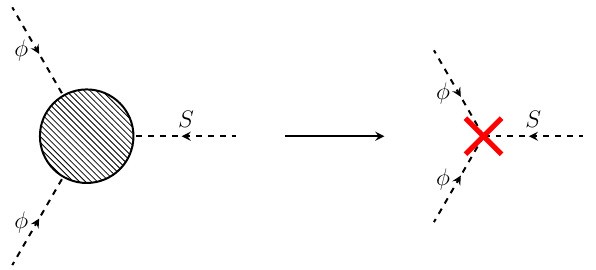
Figure 5 . For the SM Higgs (cid:30) and the scalar singlet S transforming as ( 1 ; 1 ; Standard Model gauge group, the local operator (cid:30) ( x ) (cid:30) ( x ) S ( x ) (right) is automatically zero, as the contraction under SU(2) L of two doublets to a singlet is antisymmetric. On the contrary, the non-local operator (cid:30) ( x 1 ) (cid:30) ( x 2 ) S ( x 3 ) (left) does not vanish in general, but implies the di(cid:11)erence of two diagrams [26].